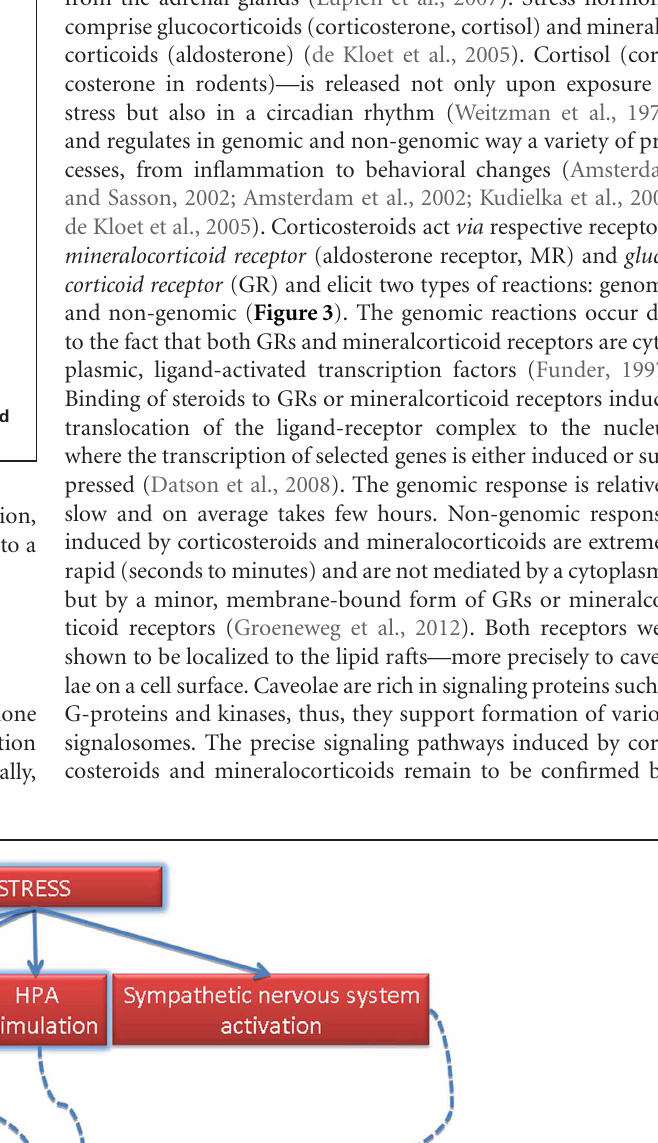
FIGURE 1 | Schematic representation of two main types of stress and different stress models used in basic research.